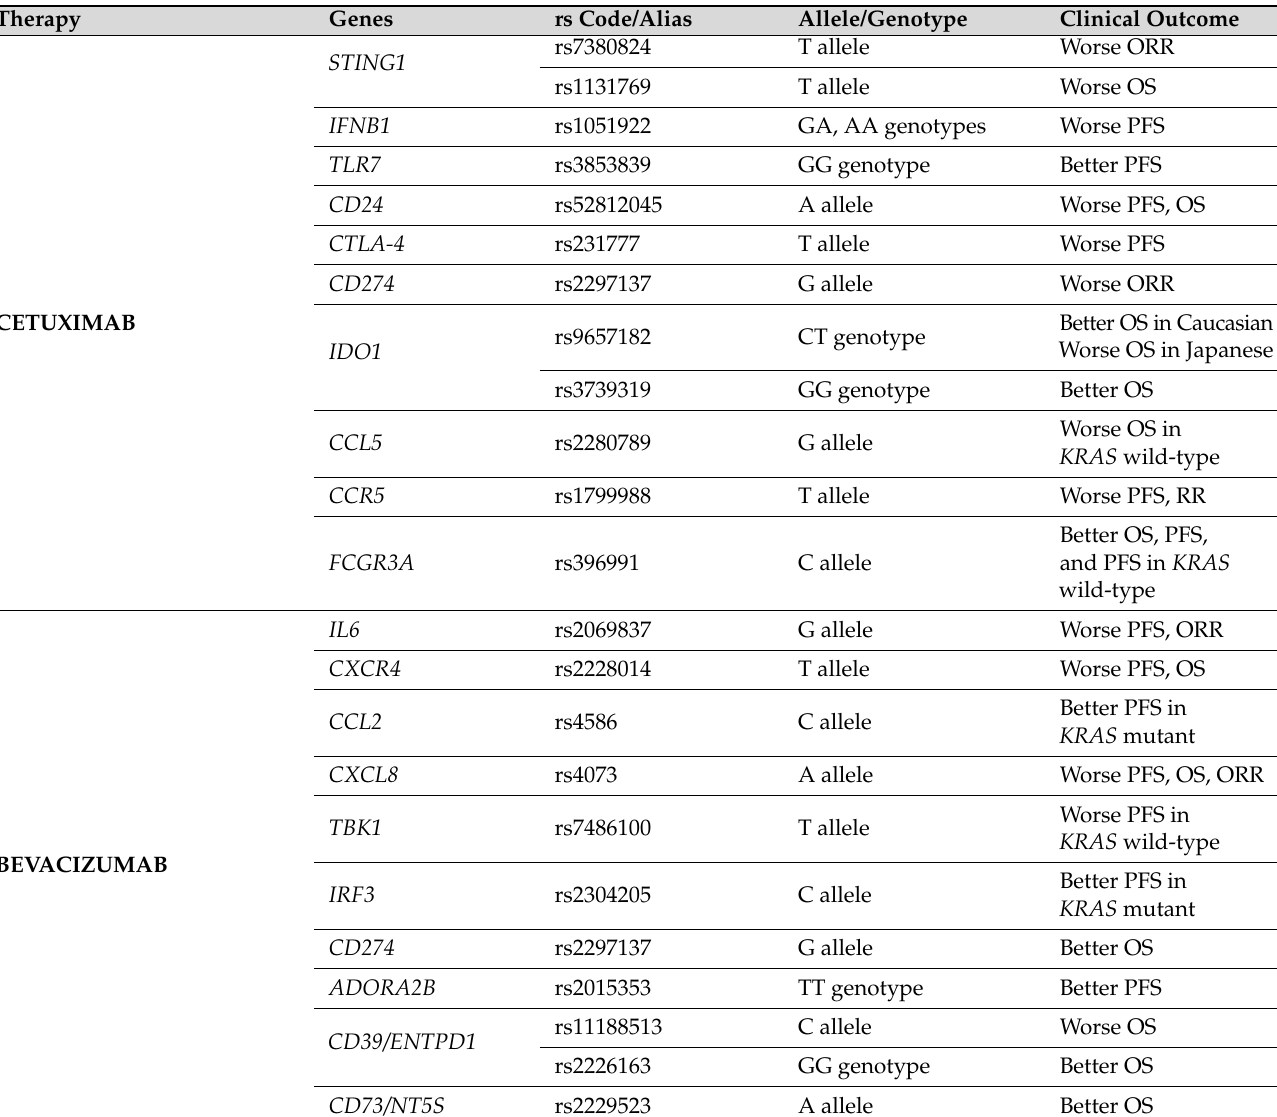
Table 2. Final summary with high-level evidence for efficacy and toxicity focusing on